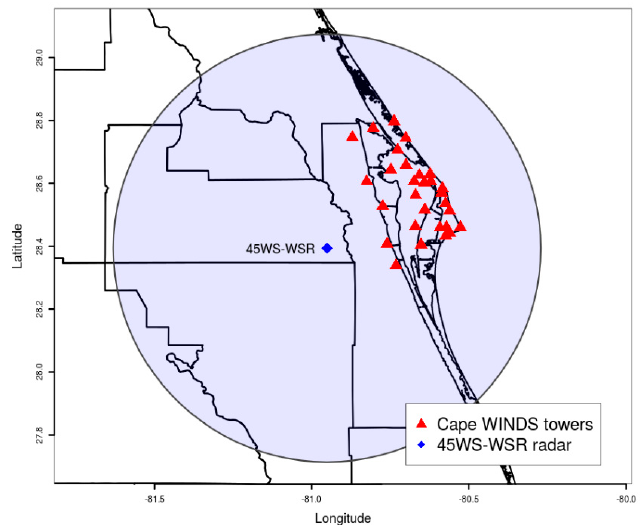
Figure 1. Cape WINDS tower locations around CCAFS/KSC (red), the 45WS-WSR radar location (blue), and the approximated 67 km range from the 45WS-WSR radar (shaded blue). Data from KXMR soundings launched at the CCAFS, typically at 00:00, 10:00, and 15:00